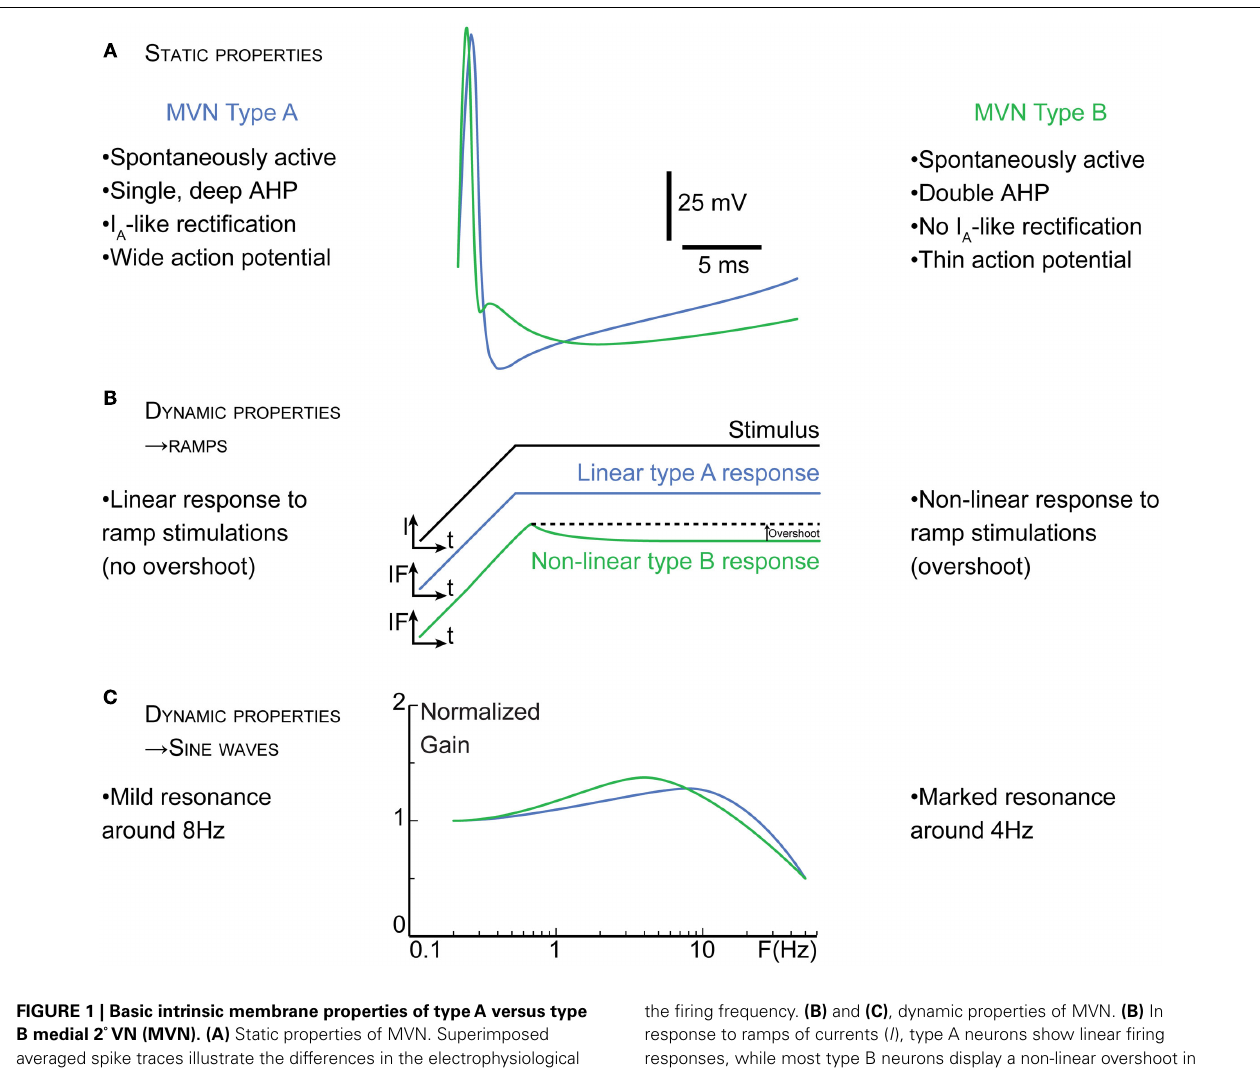
FIGURE 1 | Basic intrinsic membrane properties of typeA versus type B medial 2˚VN (MVN). (A) Static properties of MVN. Superimposed averaged spike traces illustrate the differences in the electrophysiological signatures of type A (blue traces) and type B (green traces) neurons.The most salient characteristics such as the differences in the afterhyperpolarization are summarized.Transient A-type K + channels (I A ) in neurons are implicated in the delay of the spike onset and the decrease in